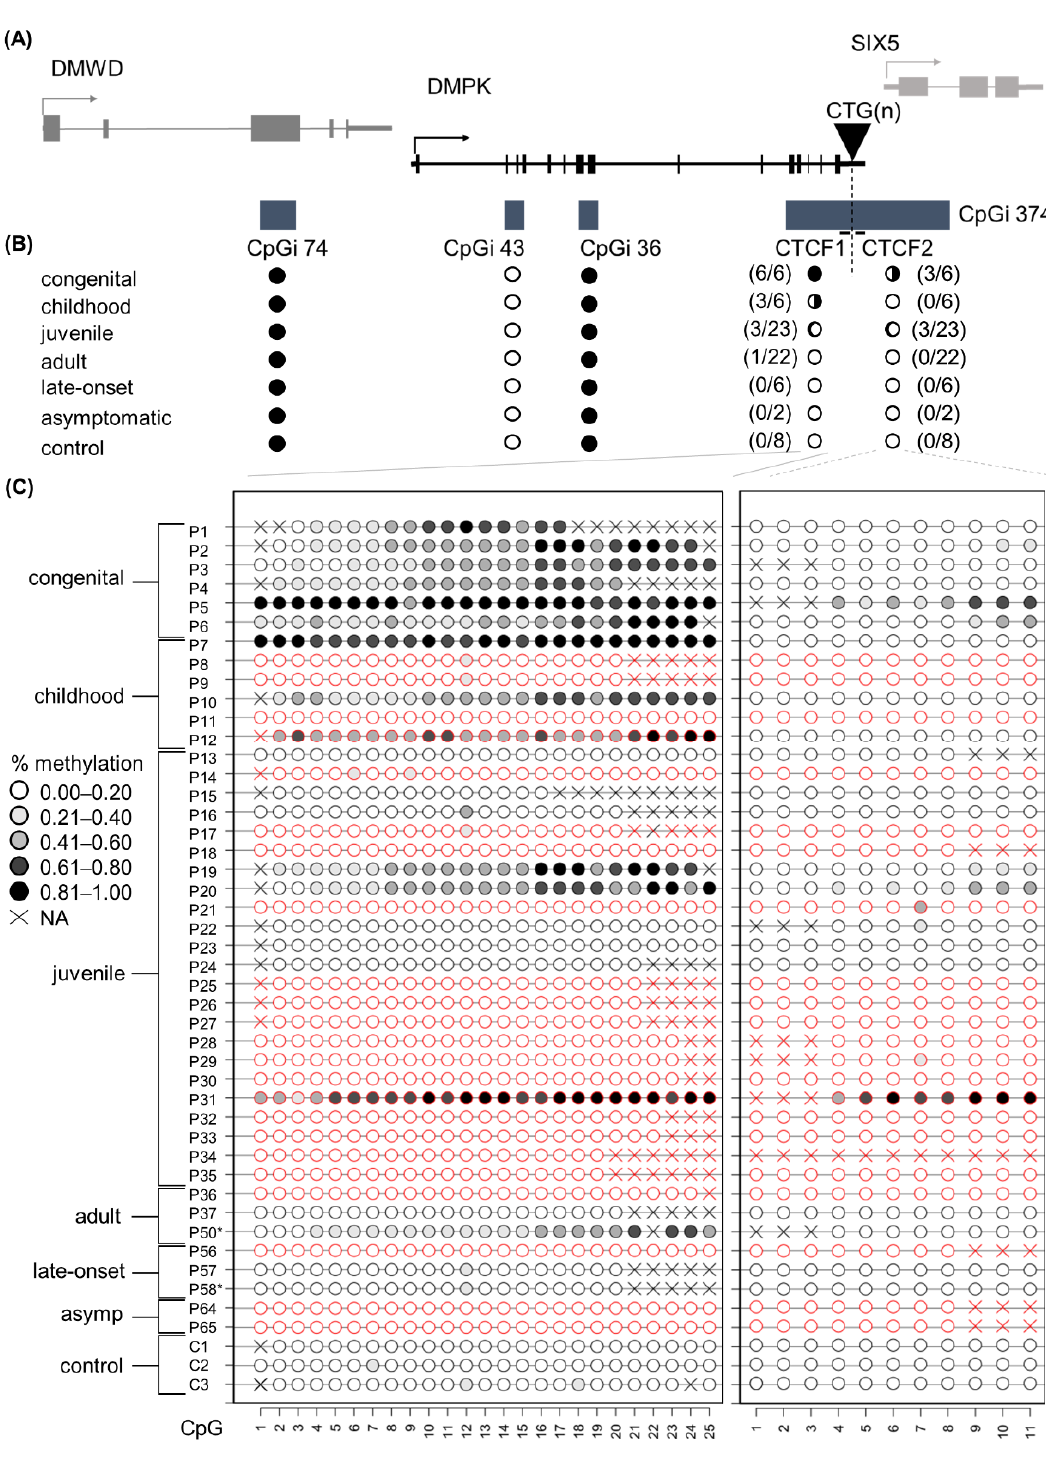
Figure 1. DNA methylation profile at the DMPK locus in DM1 blood samples representing all clinical subtypes. ( A ) Schematic representation of the four CpGis residing in the DMPK locus and neigh- boring genes. CpGi 374 is divided into the CTCF1 and CTCF2 region, harboring the CTCF binding sites and encompassing the CTG expansion. ( B ) Summary of the methylation profiles of the five CpG regions across the DMPK locus in the studied clinical subtypes, in which black indicates the degree of methylation. Congenital n = 6, Childhood n = 6, Juvenile n = 23, Adult n = 22, Late onset n = 6, asymptomatic n = 2, Controls n = 8. ( C ) Detailed DNA methylation profiles of the clinical subtypes in the CTCF1 and CTCF 2 regions. Each circle represents a CpG dinucleotide. The colour gra- dient represents the level of methylation indicated in the legend assessed by sodium bisulphite se- quencing. Red indicates paternal inheritance. Black indicates maternal inheritance. * means un- known inheritance. For the non-developmental cases, only a representative subset of three samples